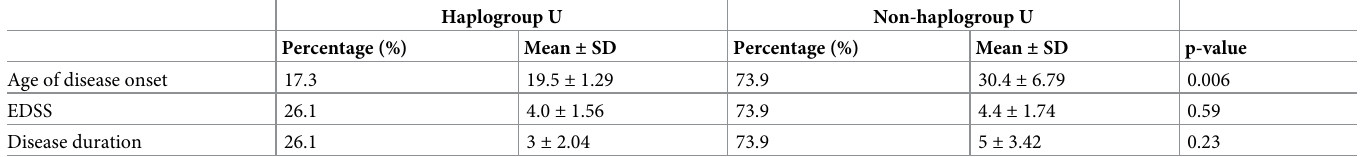
Table 3. Relationship between haplogroup U and clinical parameters in RRMS